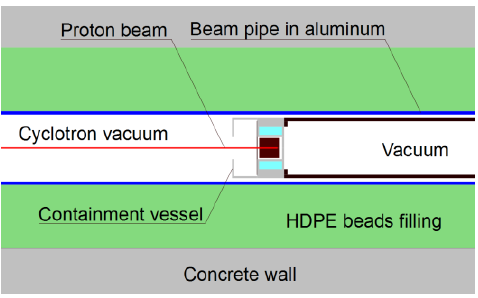
Fig. 2 Schematic representation of the target system inside the conduit through the cyclotron concrete shield wall (grey). In green, the polyethylene filling in the gap between the vacuum line and the wall. A composite material plug (in black) is used to insert the target system and then to hold it